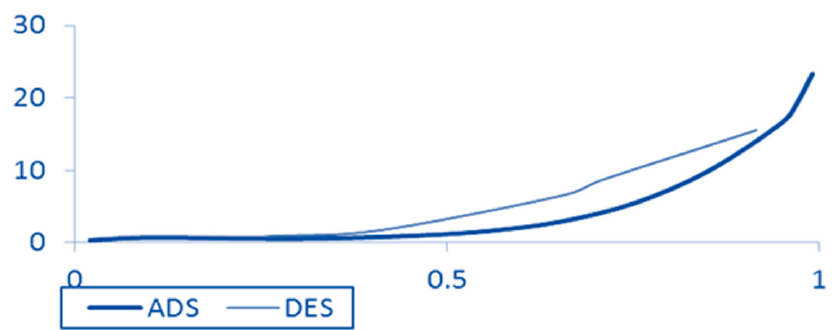
Figure 5. N 2 adsorption/desorption isotherms of zirconium magnetic nanocomposite.